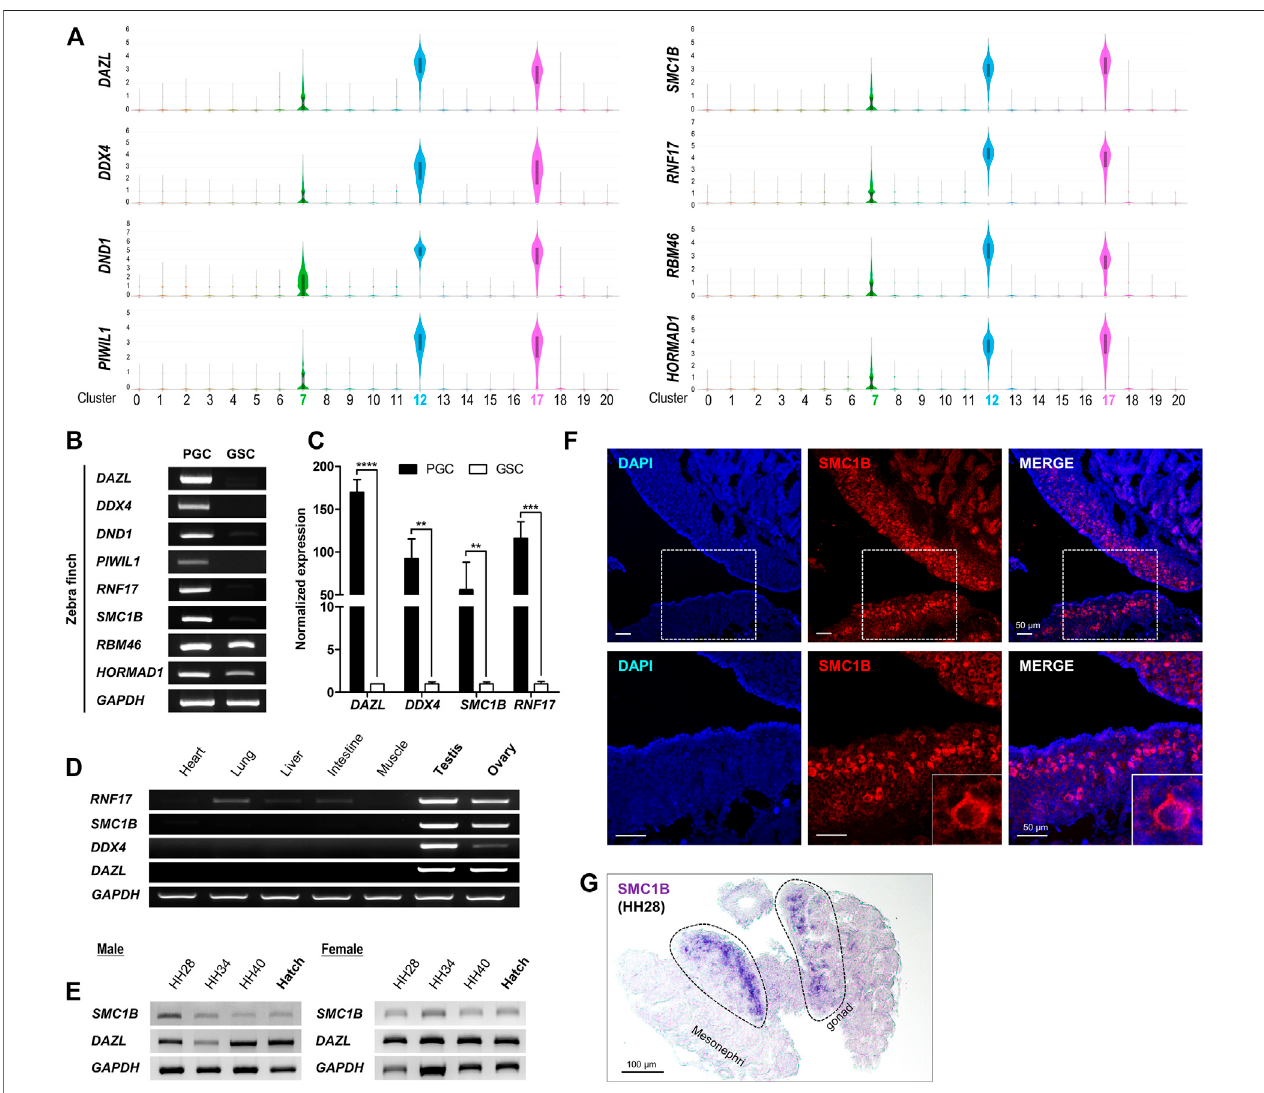
FIGURE 4 | Identi fi cation of novel marker genes for zebra fi nch gonadal PGCs. (A) Selected genes from the top 20 DEGs in each PGC cluster. The number of the Y -axis mean log values. (B) RT-PCR analysis of selected genes in PGCs and GSCs. (C) Quantitative RT-PCR analysis of selected genes. Signi fi cant differences are shown (Student ’ s t-test; **** p < 0.0001; *** p < 0.0005; ** p < 0.005). (D) Tissue-speci fi c expression of selected genes. (E) Expression of selected genes according to developmental stage. (F) Localization of SMC1B to gonadal cells was analyzed by immunohistochemistry using anti-SMC1B antibodies in zebra fi nch embryonic gonads at HH stage 28. The dotted boxes in the upper panels are enlarged and shown in the lower panels. (G) In situ hybridization of SMC1B in zebra fi nch embryonic gonads at HH stage 28.